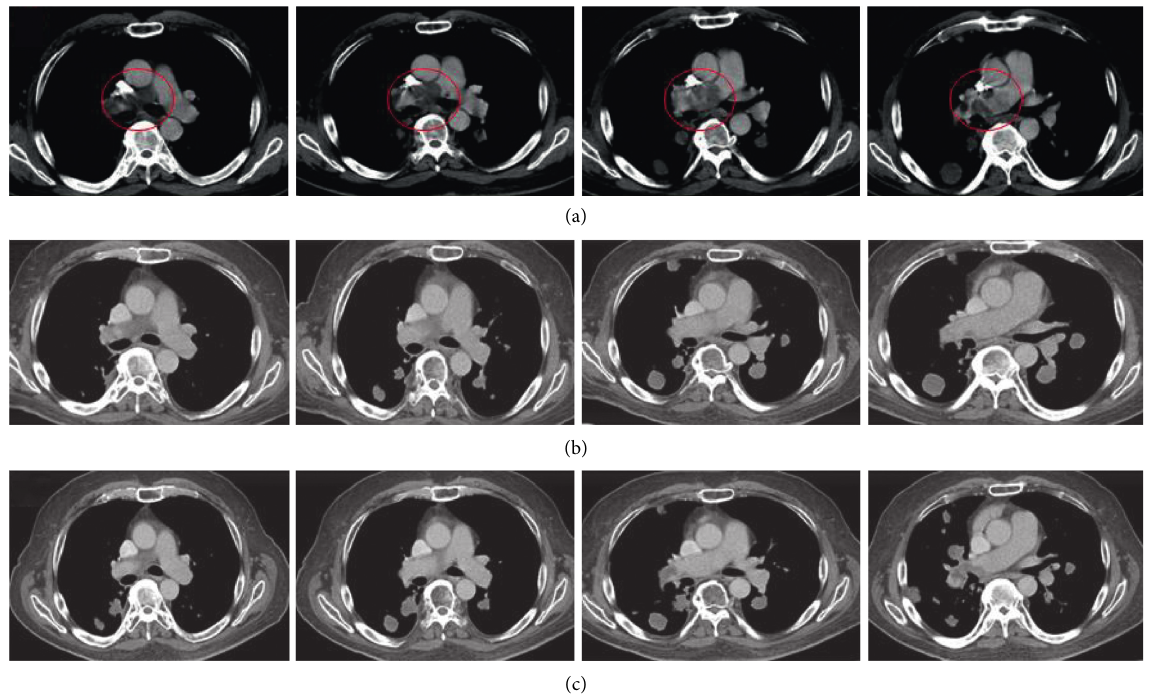
Figure 2: (a) Initial CTof the chest showing large intravascular mass encasing the right main pulmonary artery. (b) Repeat CTchest after 6 cycles of doxorubicin, displaying partial reduction of the primary pulmonary mass and metastatic lesions. (c) After 3 cycles of palbociclib, the patient had stable